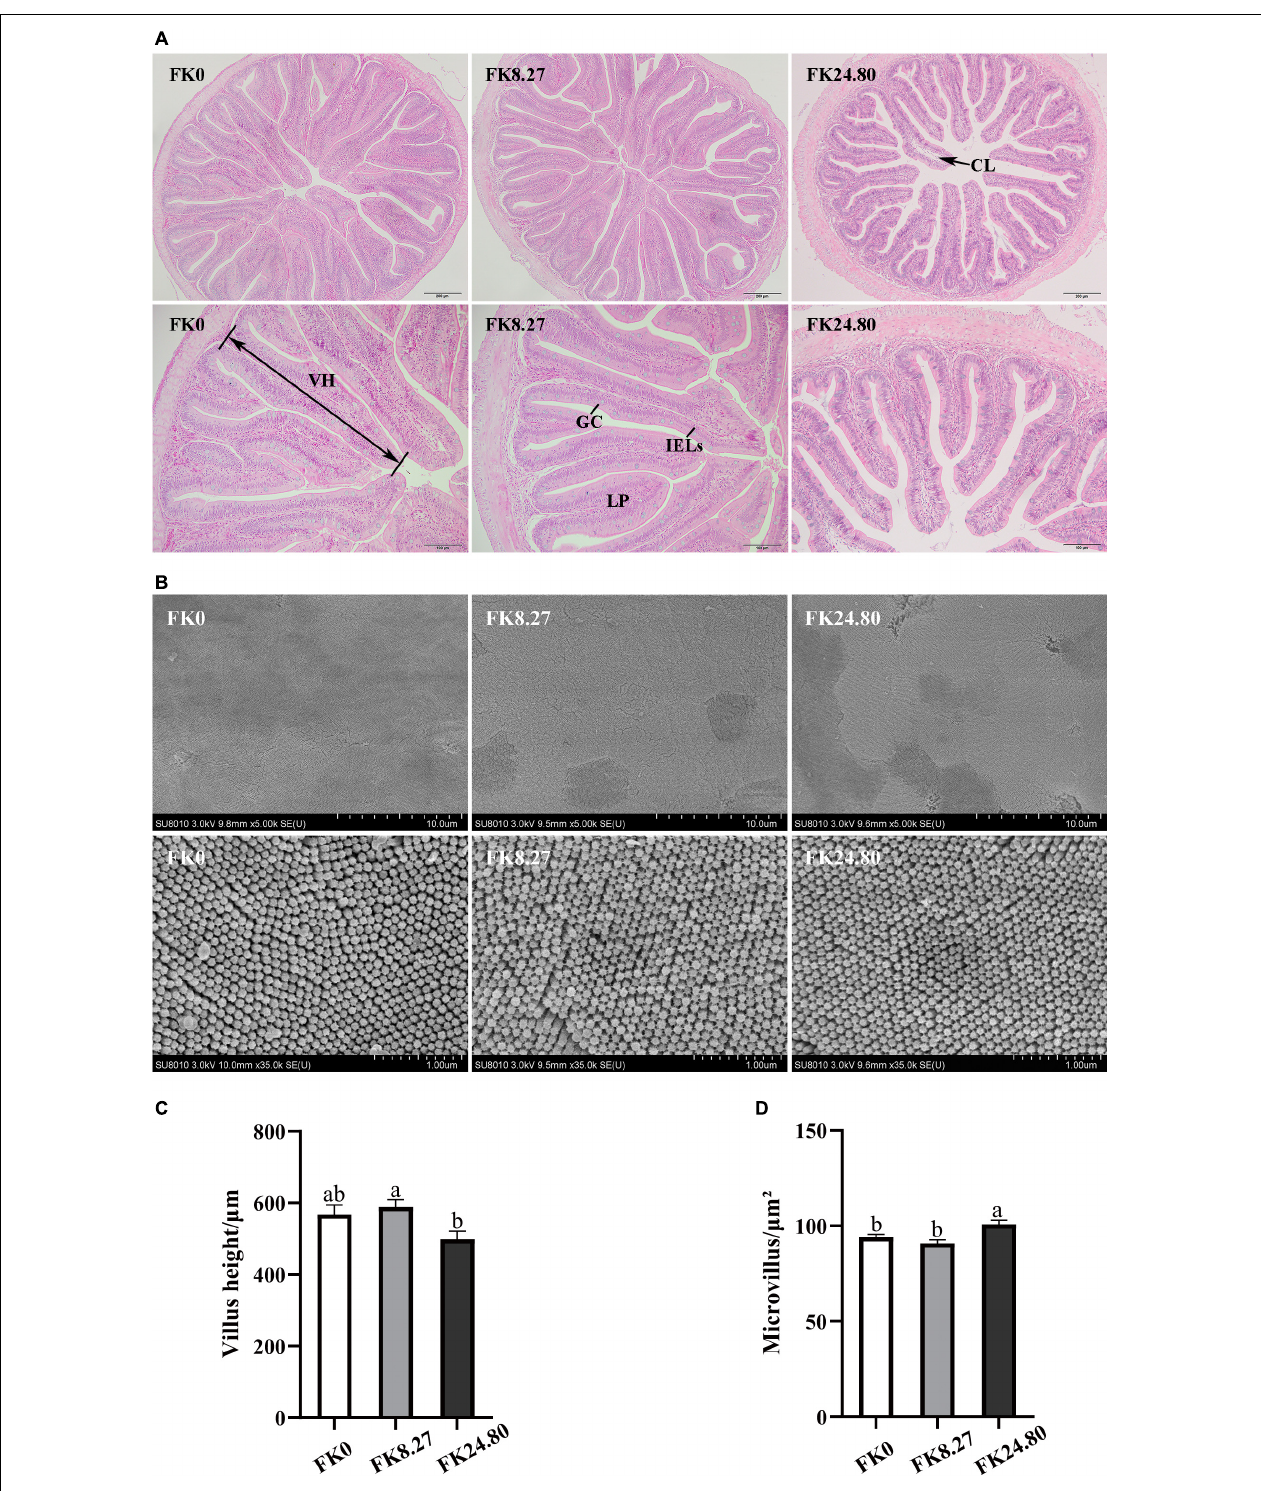
FIGURE 1 | Intestinal histomorphological observation and statistics of black sea bream fed FK0, FK8.27, and FK24.80 diets for 10 weeks. (A) Representative histomorphological images from hematoxylin and eosin-stained midgut transverse section (100 × /200 × ), single arrows indicate vacuoles in the lamina propria; (B) representative scanning electron microscope images of ultrastructure of the midgut epithelium surface (5.00 k × /35.0 k × ); (C) mean ( ± SEM) height of villus in midgut ( n = 3); (D) mean ( ± SEM) number of microvillus per µ m 2 in midgut ( n = 3). a , b Means with different superscripts are significantly different ( P < 0.05). VH, villus height; LP, lamina propria; GC, goblet cell; IELs, intraepithelial leucocytes; CL, central lacteal.